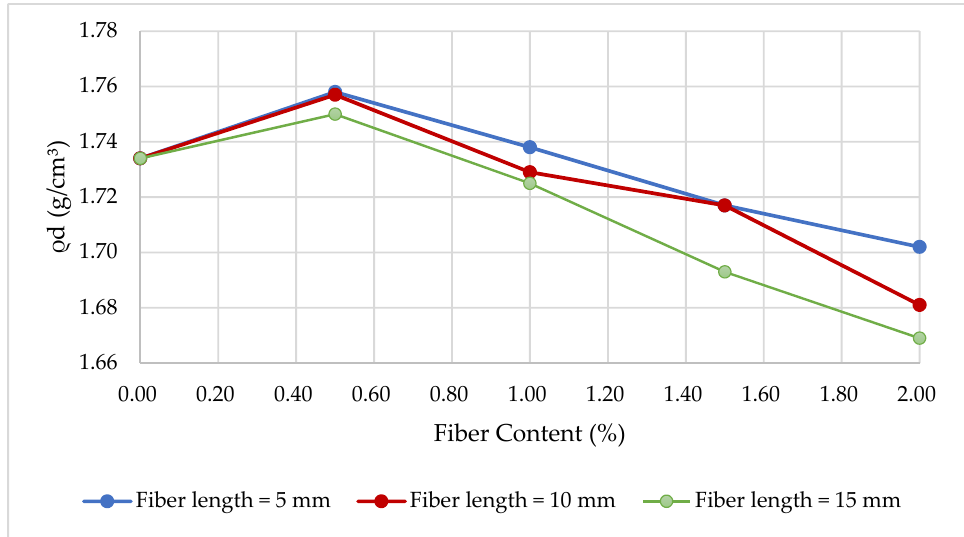
Figure 9. Max. Dry density vs. Fiber Content . Table 5. Linear mixed model examining the effect of condition on the log10 transformed effort. The model used ID as a random effect with control as a reference category. The estimation procedure was computed using REML.